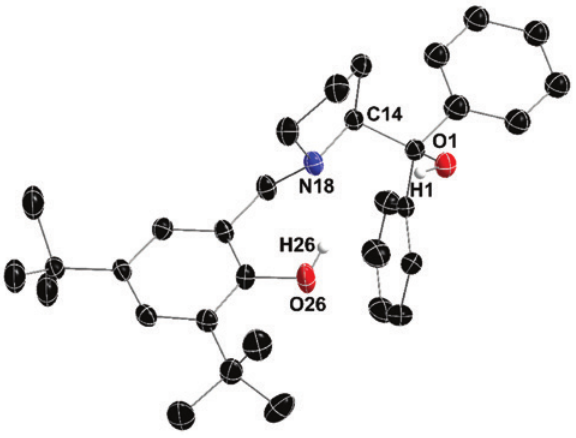
Figure 3: ORTEP representation of the molecular solid-state struc- ture of the enantiomerically pure proteo-ligand ( S )-{OˆO}H only the main component of the disordered p - t Bu group. H atoms other than those on oxygen atoms omitted for clarity. Ellipsoids drawn at the 50% probability